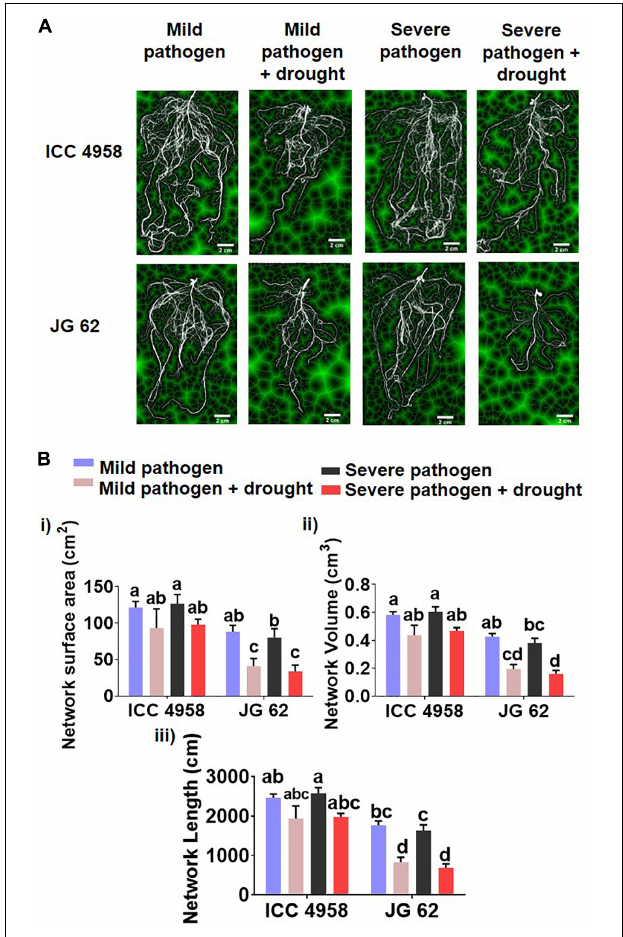
FIGURE 3 | Root images indicating the differential attachment of M. phaseolina microsclerotia on the ICC 4958 and JG 62. ICC 4958 showed resistance to DRR pathogen (MH509971.1) infection. ICC 4958 and JG 62 were subjected to infection by microsclerotia under well-watered conditions using the blotting paper method (Irulappan and Senthil-Kumar, 2021). Roots were collected and examined for the number of attached microsclerotia using the scanning electron microscope. (A) Uninfected root images of ICC 4958. (B) Uninfected root images of JG 62. (C) Infected ICC 4958 roots showing attached microsclerotia. (D) JG 62 roots show the attached microsclerotia. (E) Mycelial growth on ICC 4958 roots. (F) Extensive growth of mycelia from the attached microsclerotia in JG 62. (G) The graph shows the variation in attached microsclerotia. Two-way ANOVA was used. Asterisks show the significance at **** p ≤ 0.0001. N = 5. The experiment was repeated three times at